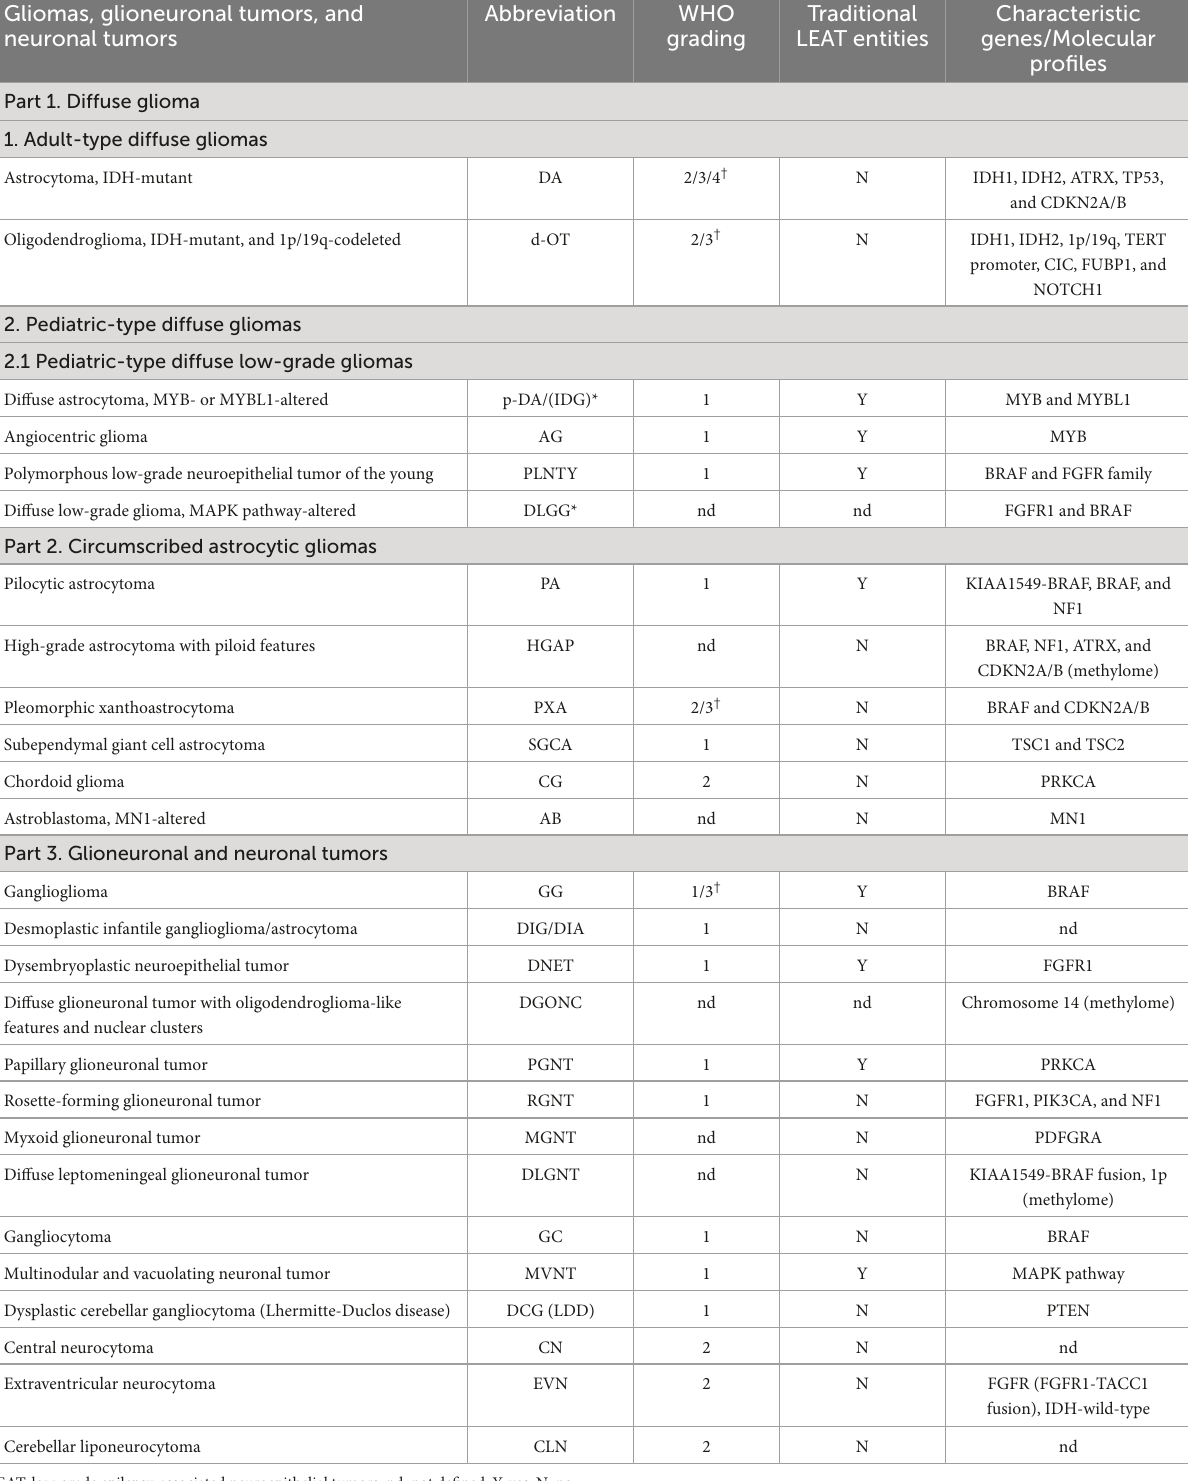
TABLE 1 The grouping of low-grade gliomas, glioneuronal/neuronal tumors based on the 2021 WHO classification of CNS tumors and the tumor spectrum of LEAT. Gliomas, glioneuronal tumors, and neuronal